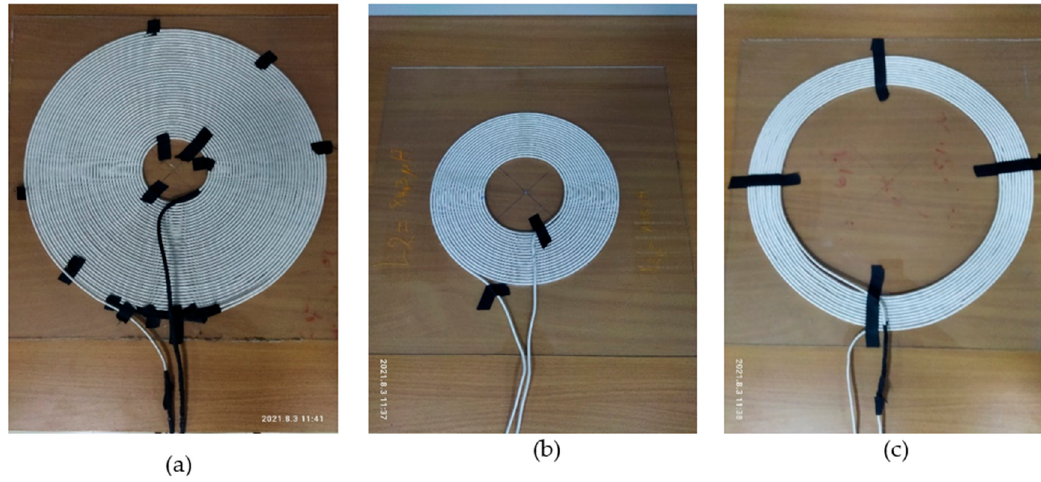
Figure 19. Magnetic field distribution of the pair of coils Coil1–Coil2.